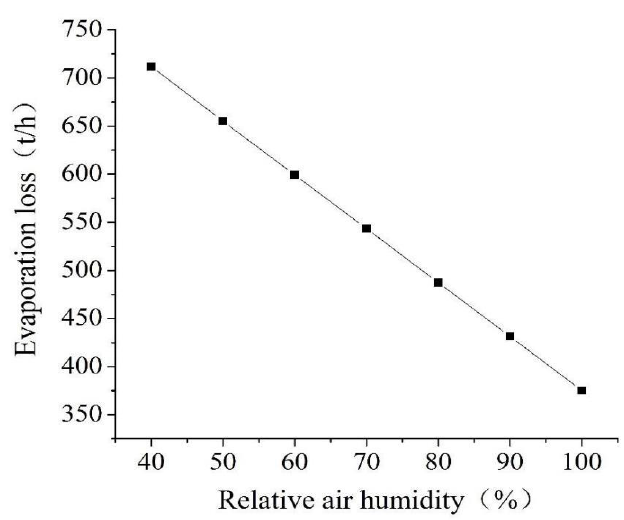
Figure 7. Outlet tower water temperature and relative air humidity.